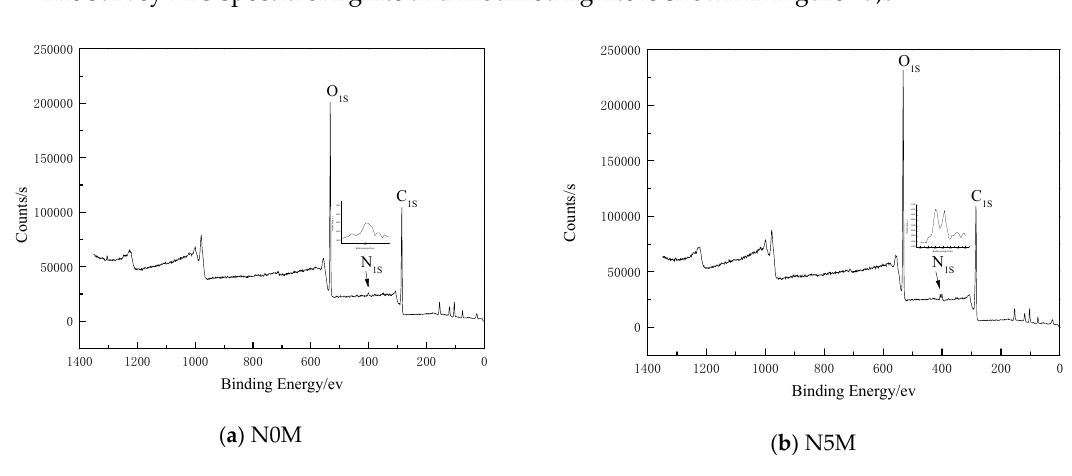
Figure 7. Survey X-ray photoelectron spectra of raw lignite and the modified lignite sample.